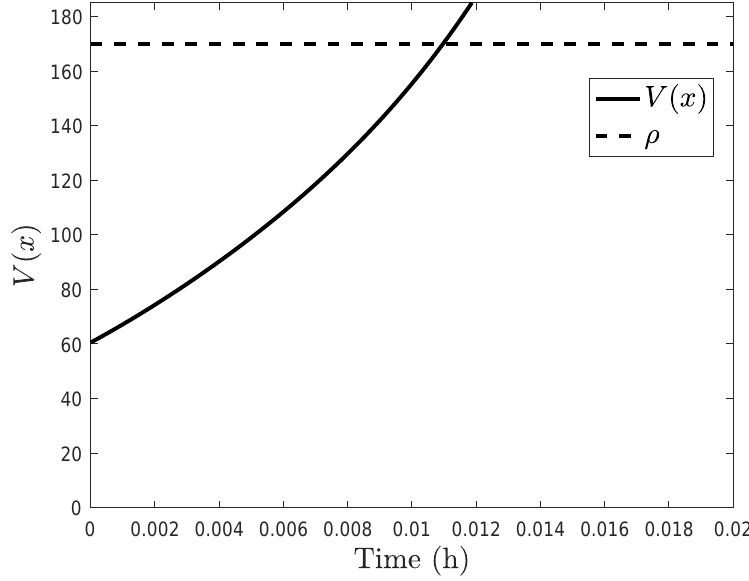
Figure 17. V ( x ) throughout the first sampling period with x 1 = 0.2 kmol/m 3 and x 2 = 5 K and ρ (cid:48) =